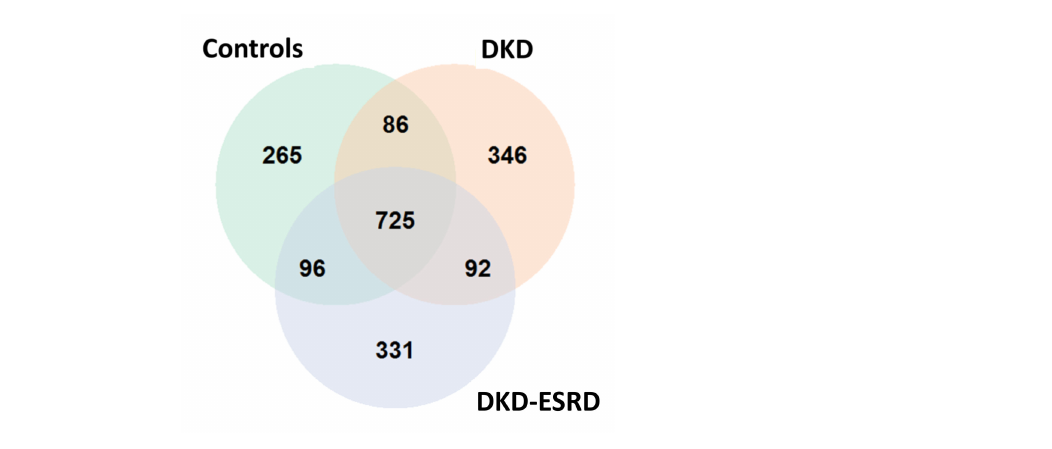
Figure 1. Venn diagram showing the distribution of identified genetic variants in controls and DKD patients with and without end-stage renal disease (ESRD).